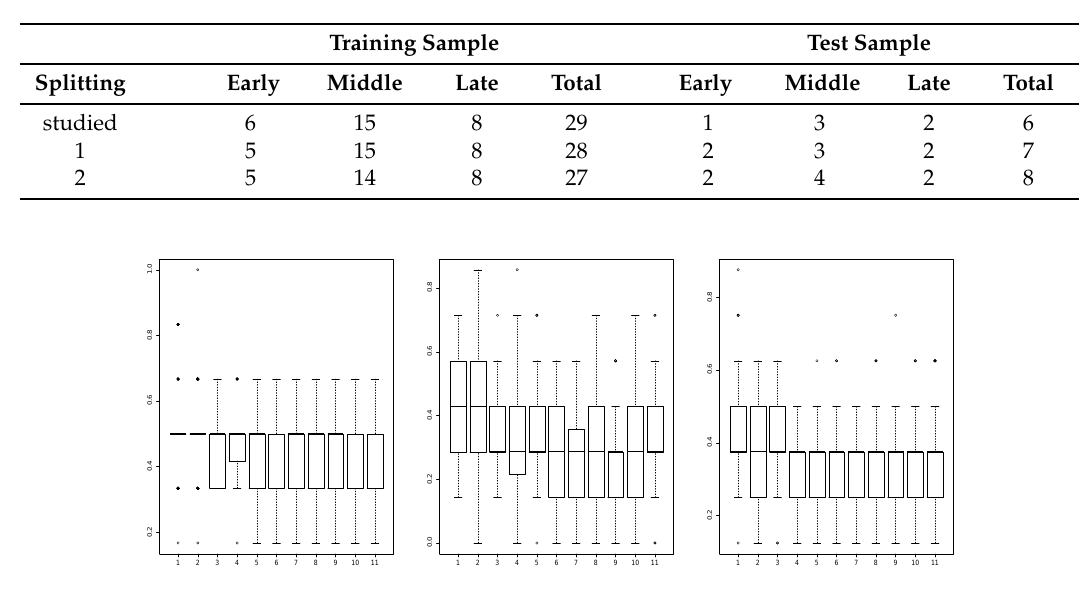
Figure 5. Boxplot of the ercentage of misclassified patients. The test data corresponding to the splitting, on training and test sample, under study ( left ), to Splitting 1 ( middle ) and to Splitting 2 ( right